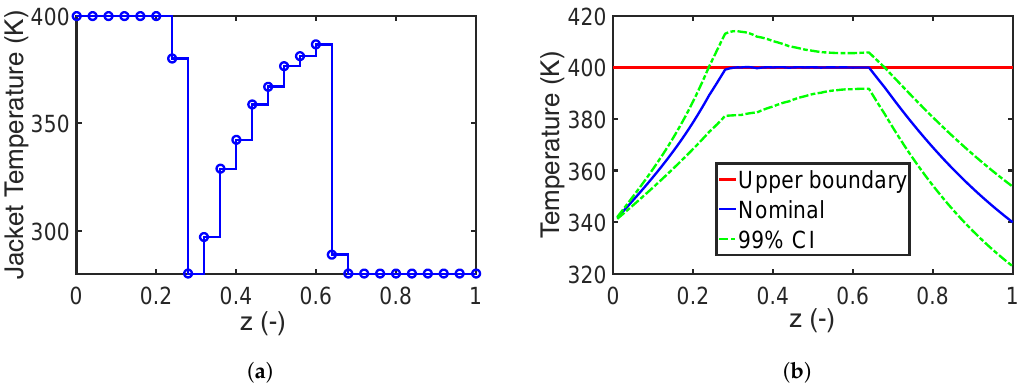
Figure 9. Results for the nominal design with terminal equality constraints: ( a ) the optimal jacket temperature profile and ( b ) the reactor temperature with its 99% confidence interval (CI). The mean and standard deviation of the conversion of reactant A are 0.980 and 0.016,